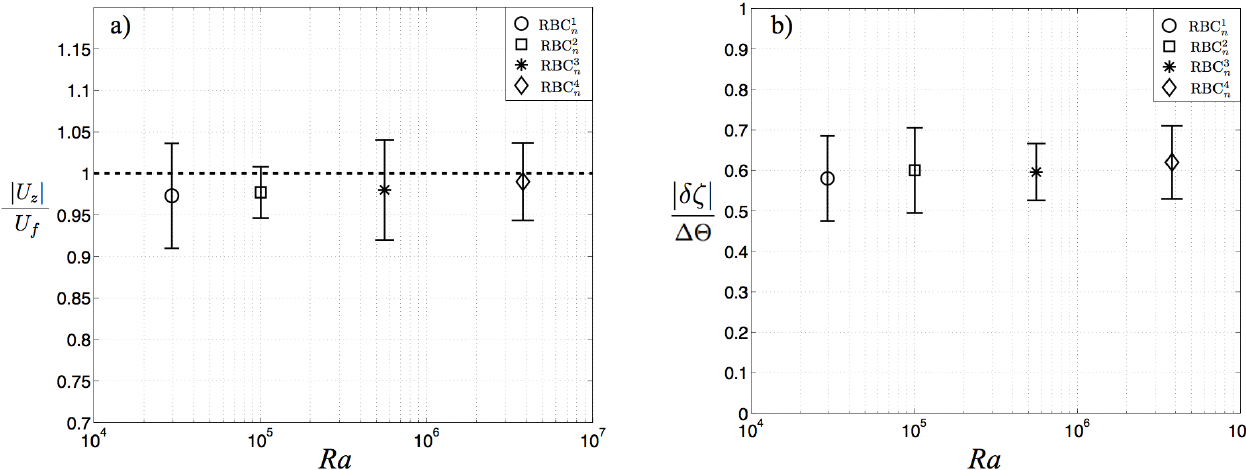
Figure 6. SFEMaNS-T RBC simulation results. ( a ) Maximum, time-averaged, mid-plane vertical flow velocity normalized by the free-fall velocity U mid-plane temperature anomalies normalized by the vertical temperature gradient ∆Θ